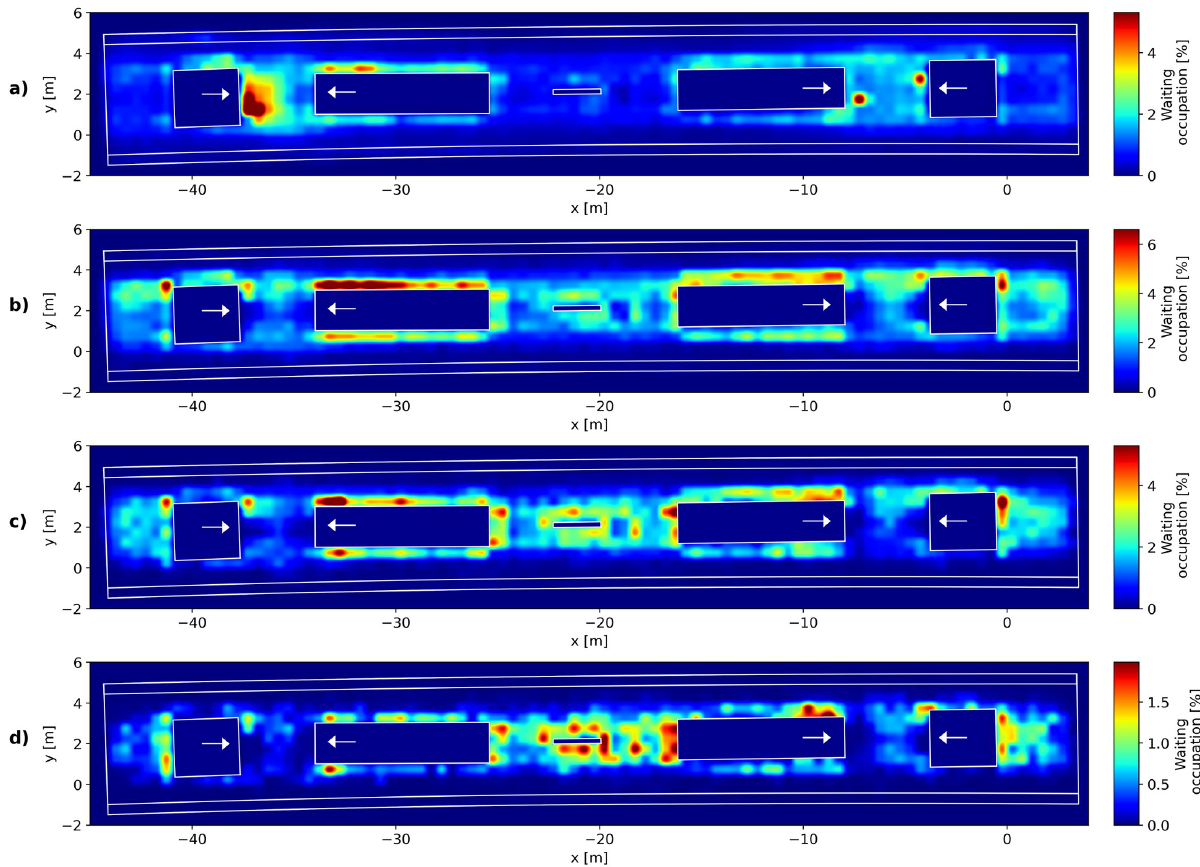
Fig 8. Waiting places of passengers depending on total waiting time. Waiting places of passengers that wait a) up to 2 minutes b) 2-5 minutes c) 5-10 minutes d) 10 and more minutes. Pedestrians with short or intermediate waiting times chose waiting places at the sides of stairs and close to obstacles, with increasing waiting times the rearward sides of stairs are used more